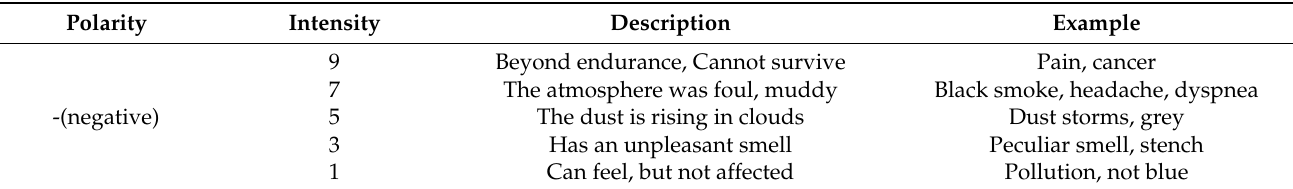
Table 2. The labeling criteria of emotion intensity.